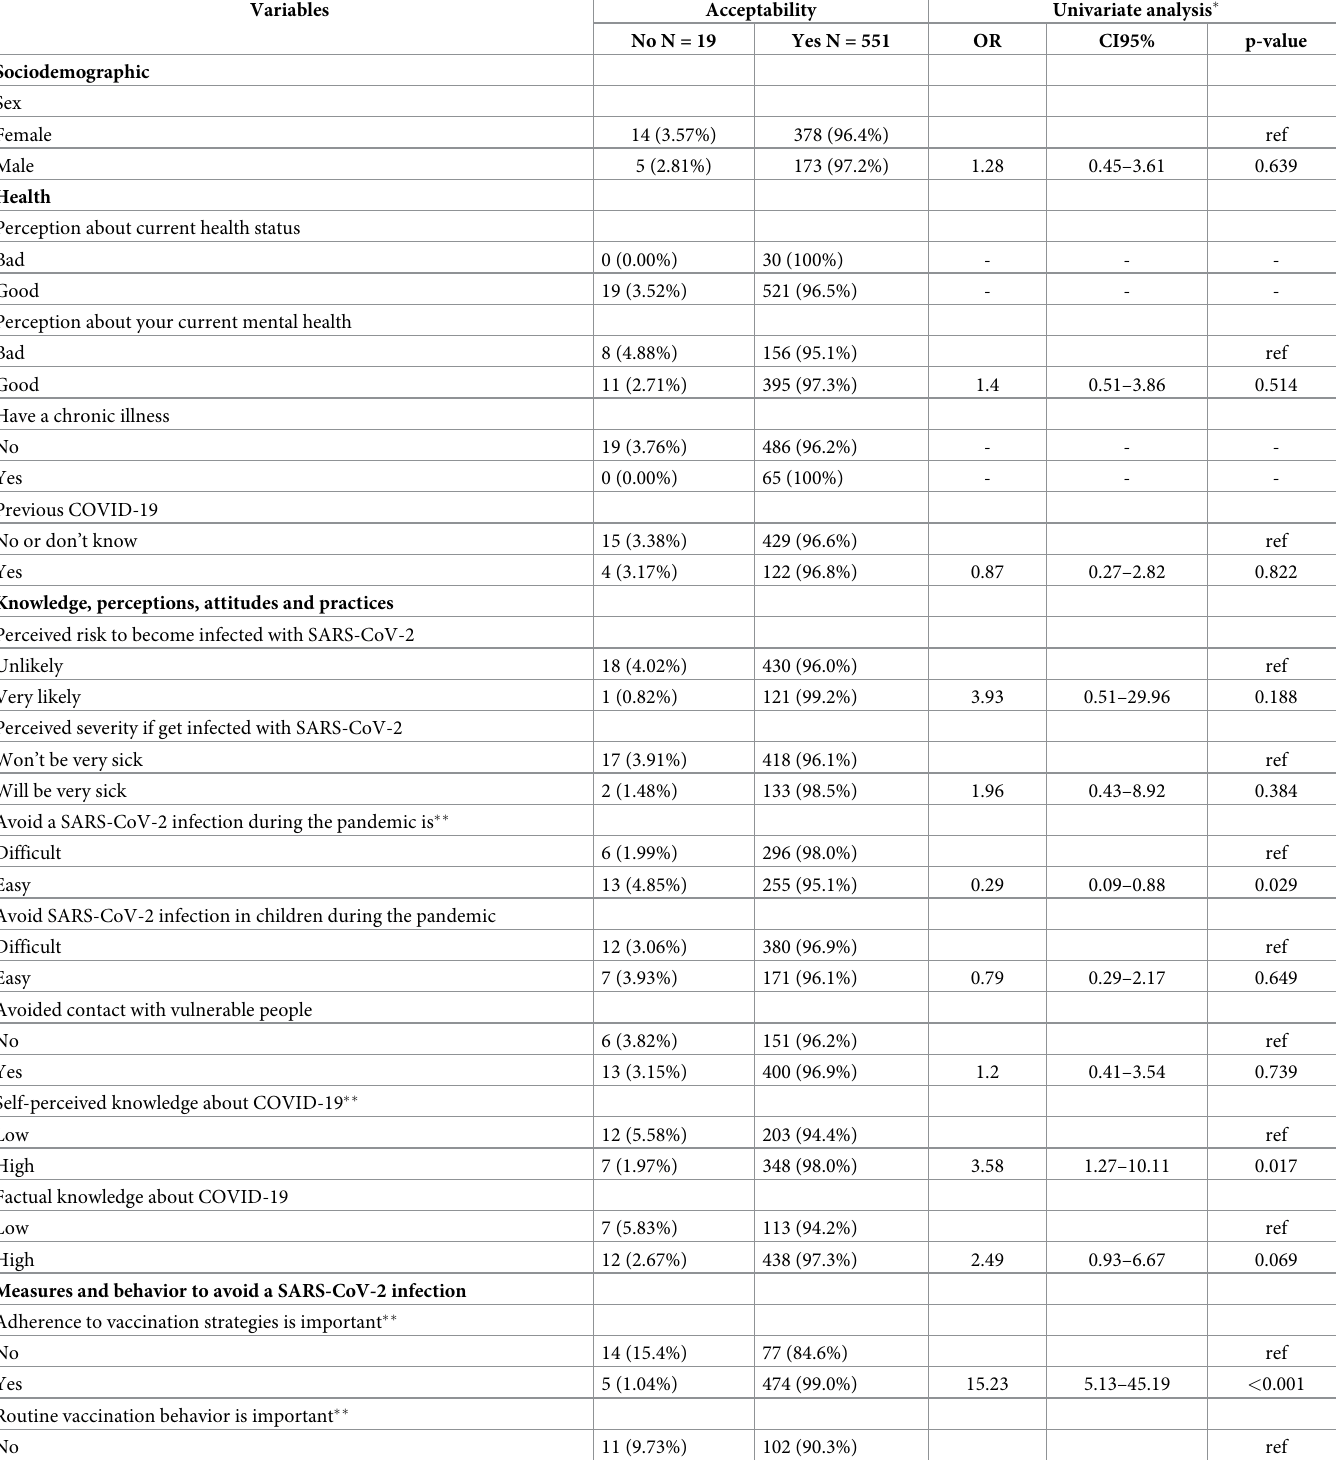
Table 3. Descriptive and univariate analysis between sociodemographic, health status, perception, attitudes and knowledge, behavior, COVID-19 related impacts and vaccine acceptability among students over 16 years in SSNC. Catalonia, January